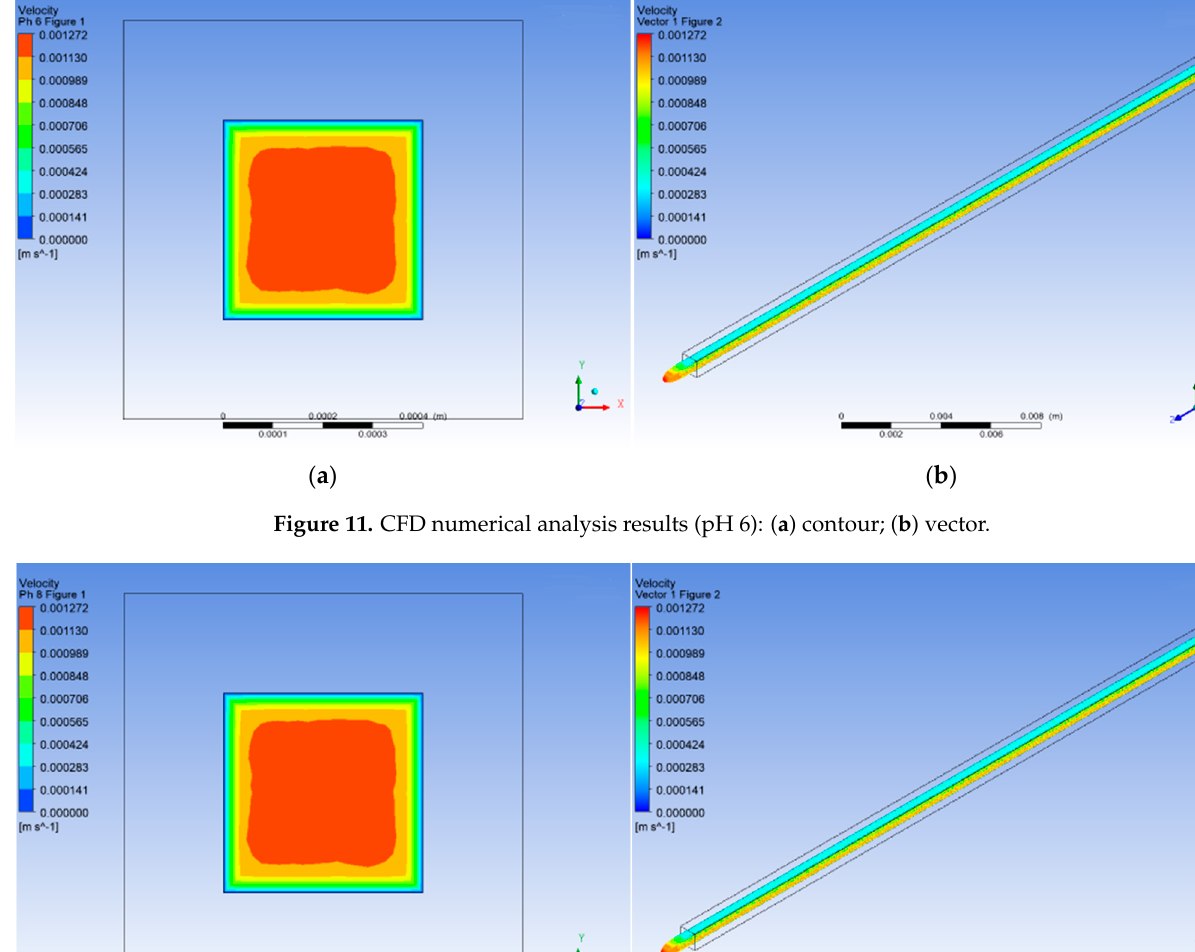
Figure 10. CFD numerical analysis results (pH 4): ( a ) contour; ( b ) vector.